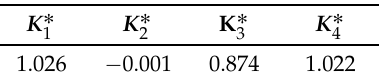
Table 3. Values of optimized coefficients obtained using the sample